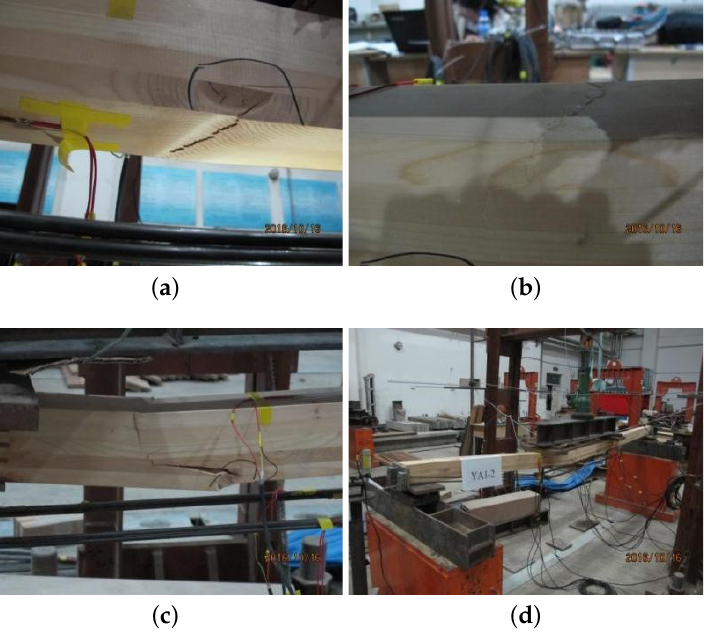
Figure 14. B1 failure mode. ( a ) bottom fibers break, ( b ) top surface wrinkle, ( c ) split above the knot and ( d ) beam